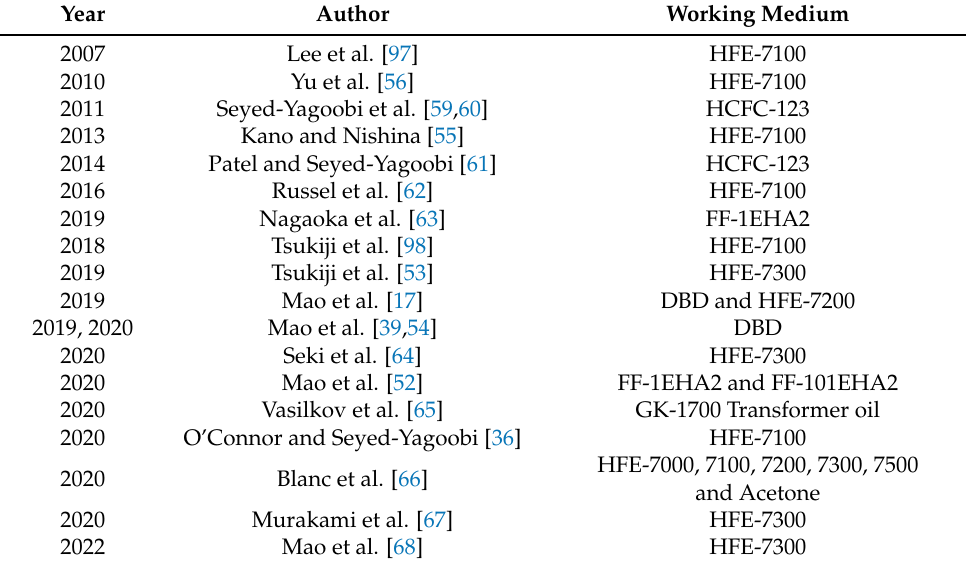
Table 4. Working medium adoption of functional fluidic EHD pumps in recent years.